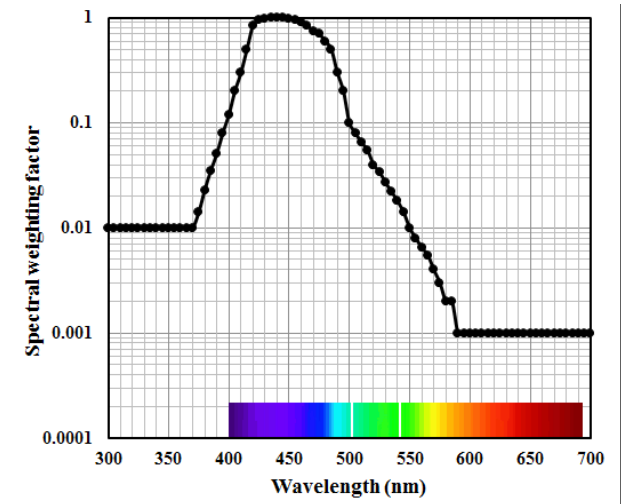
) as a function of (λ)